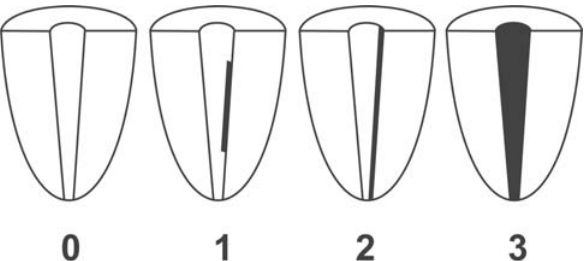
FIGURE 1- Scores of dye removal: 0 – no remaining dye;